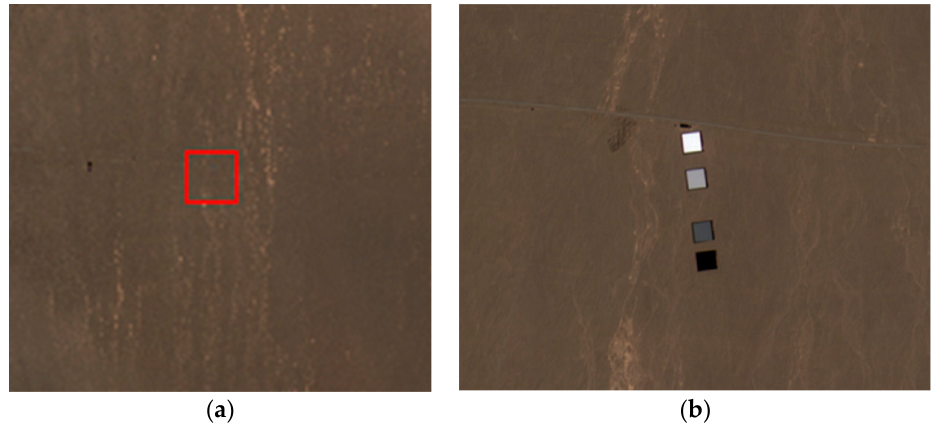
Figure 11. ( a ) Select Gobi area (in the red box) and its surrounding environment; ( b ) enlarged Gobi area (near the target).